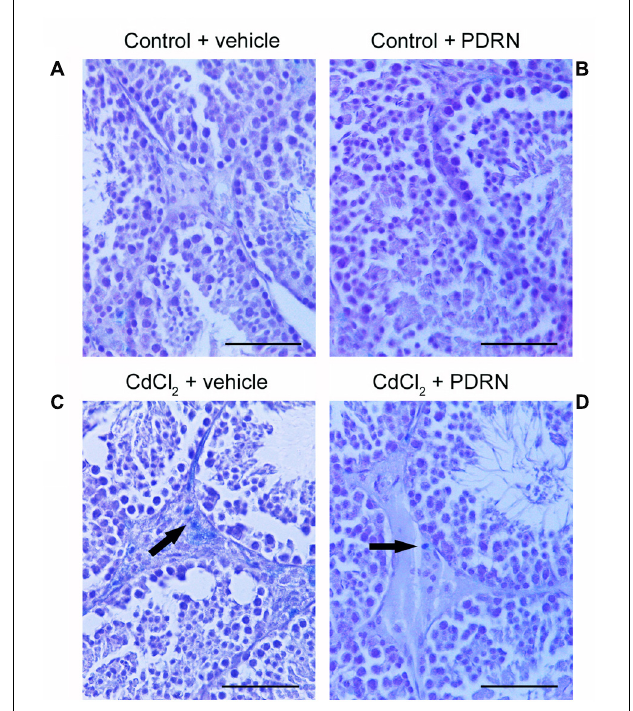
FIGURE 5 | Trypan blue staining technique revealing interstitial macrophages in the testes from control plus vehicle animals (A) , control plus PDRN (8 mg/kg i.p.) animals (B) , CdCl 2 (2 mg/kg i.p.) plus vehicle animals (C) , and CdCl 2 (2 mg/kg i.p.) plus PDRN (8 mg/kg i.p.) animals (D) . (A,B) No macrophages are present in the extratubular compartment. (C) Arrow, numerous interstitial macrophages. (D) Arrow, isolated interstitial macrophages. (Scale bar: 80 µ